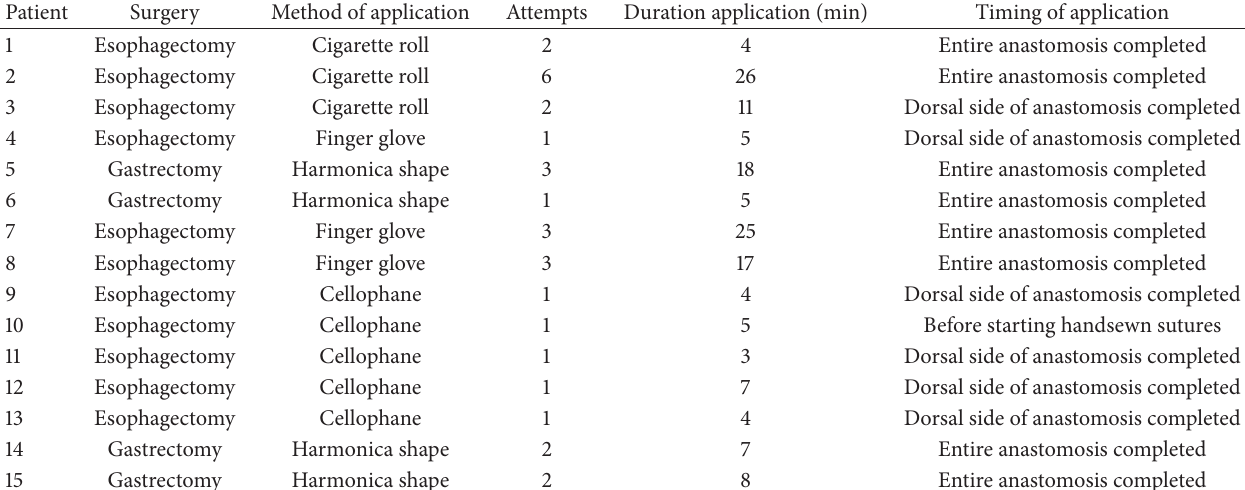
Table 2: Evaluation of methods of application.